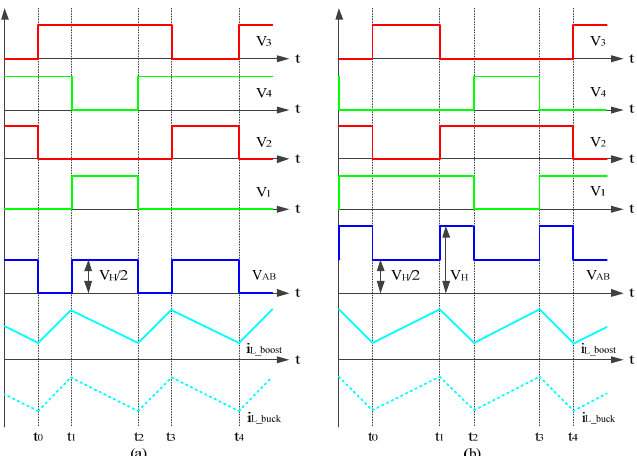
Figure 2. Key waveforms. ( a ) Boost mode (0.5 < D < 1) and buck mode (0 < D < 0.5). ( b ) Boost mode (0 < D < 0.5) and buck mode (0.5 < D < 1).